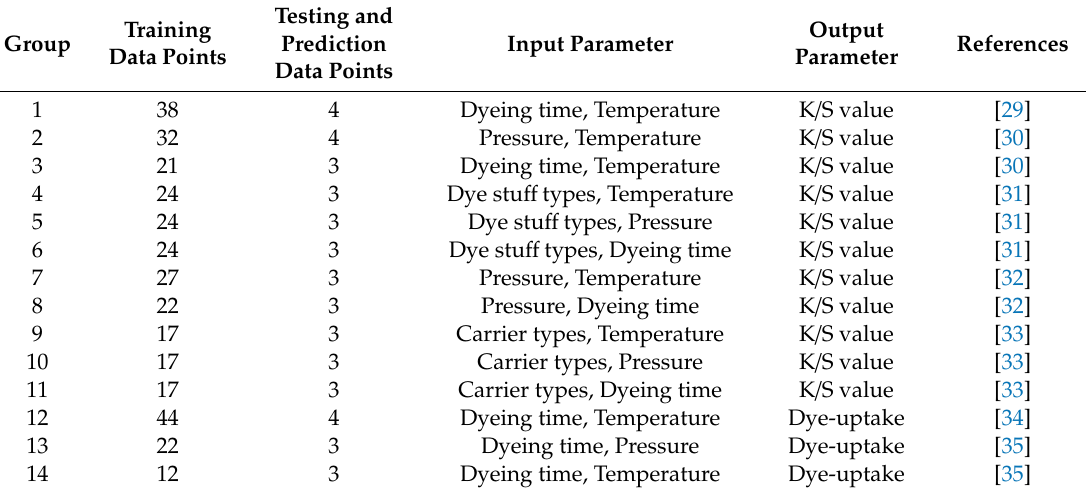
Table 1. Experimental conditions and data numbers of